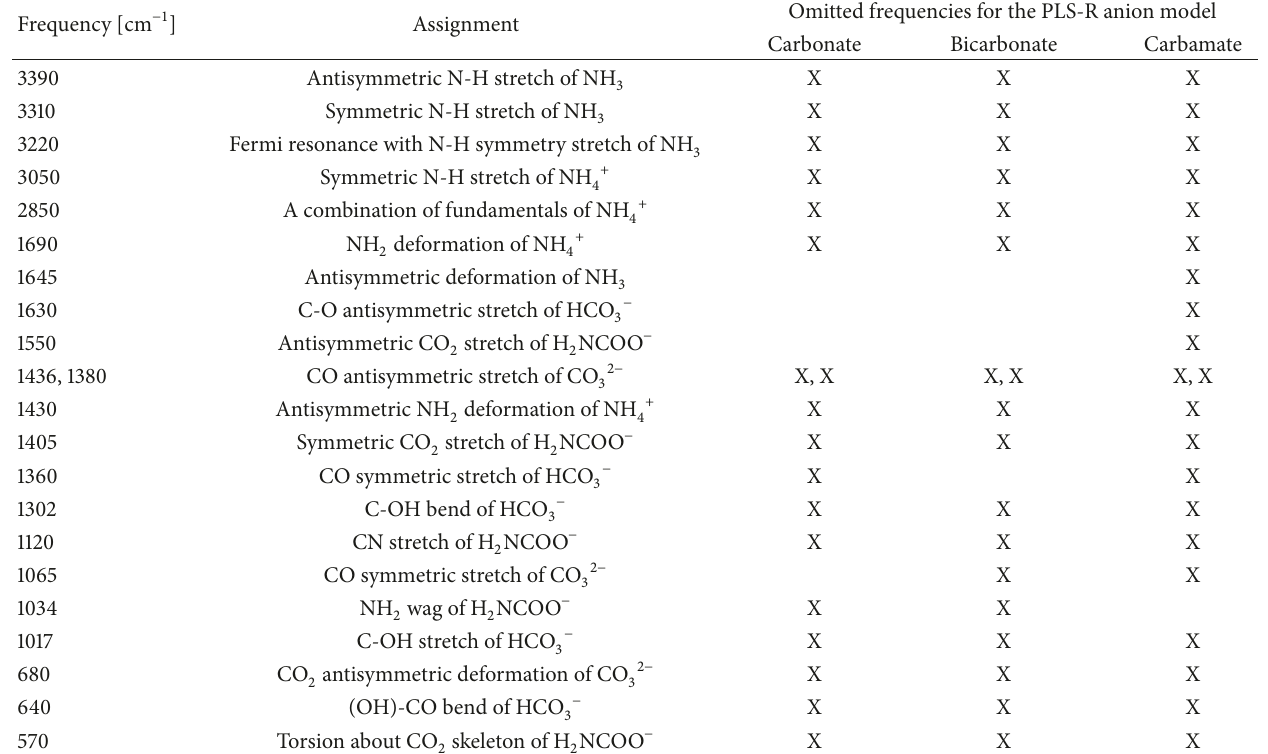
Table2:Vibrationalassignmentsof(NH 4 ) 2 CO 3 ,NH 4 HCO 3 ,andH 2 NCOONH 4 aqueoussolutions,andomittedfrequenciesintherespective PLS-R models. Adapted from the data of Wen and Brooker